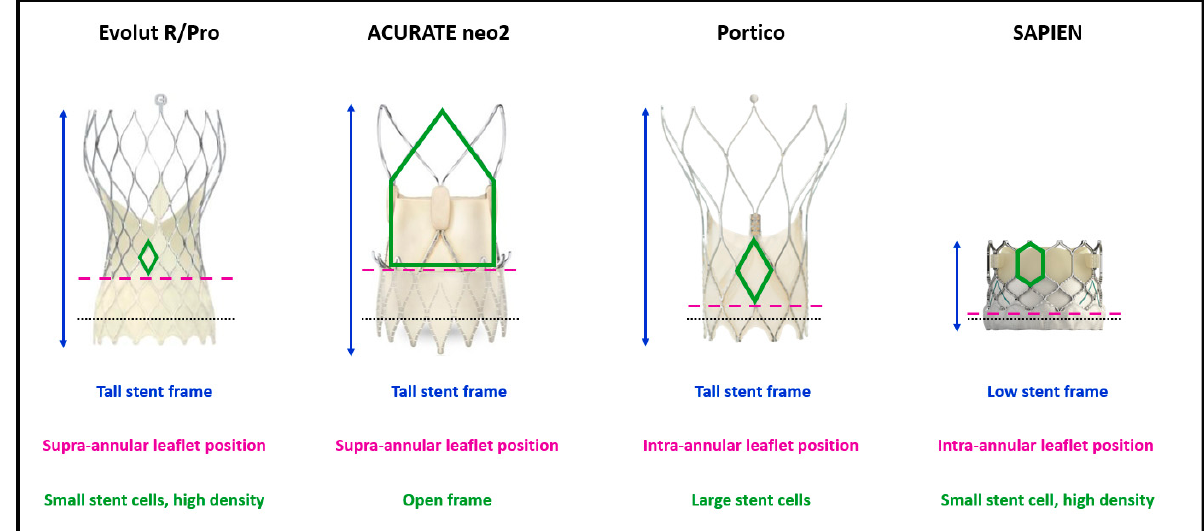
Figure 1. THV characteristics impacting coronary access after TAVR. Black dotted lines remark the level of native annulus at nominal implantation depth. THV = transcatheter heart valve. TAVR = transcatheter aortic valve replacement.